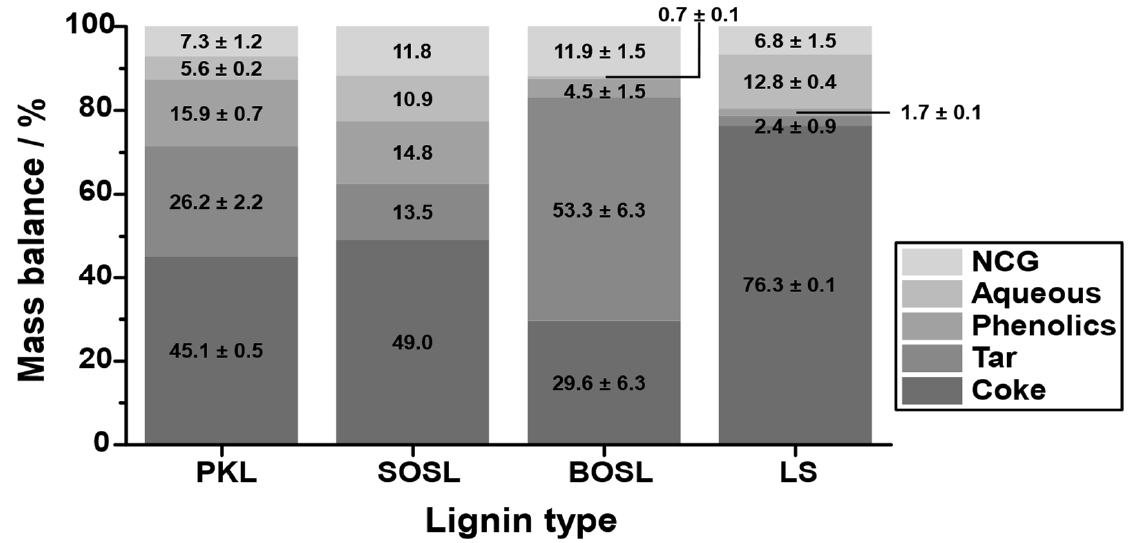
Figure 5. Mass balance including coke (very dark grey), tar (dark grey), phenolics (grey), aqueous fraction (light grey), and noncondensable gases (NCGs; very light grey) of the four technical lignins, PKL, SOSL, BOSL, and LS, after microwave-assisted